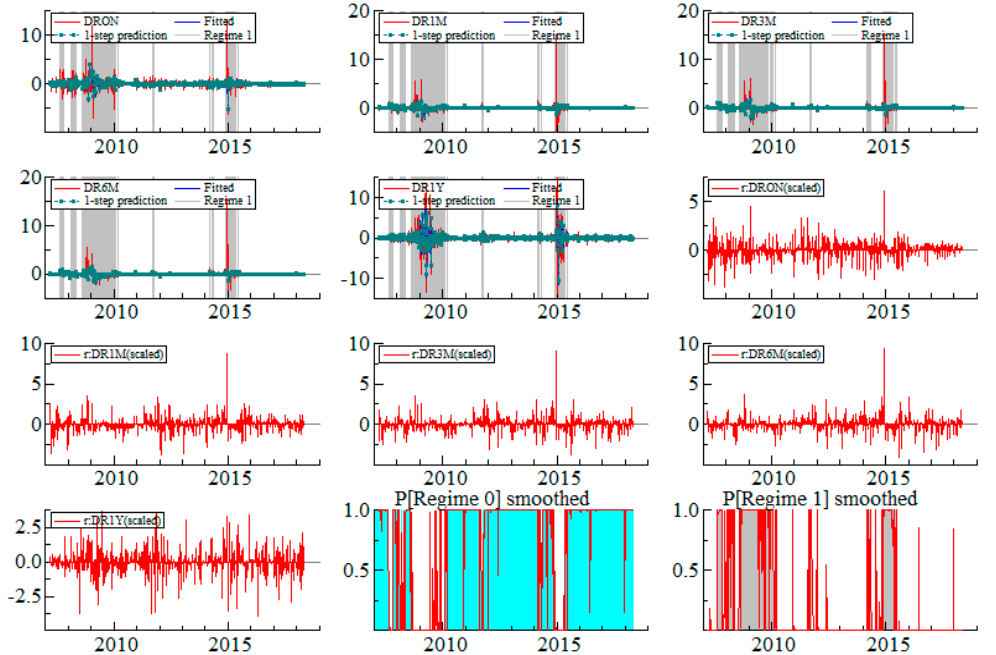
Figure A6. Russia Regime-switching modeling: Msiah (2)-Vecm (1). Note: Regime 1 denotes the high-volatility regime, whilst Regime 0 the low-volatility one [8,25].